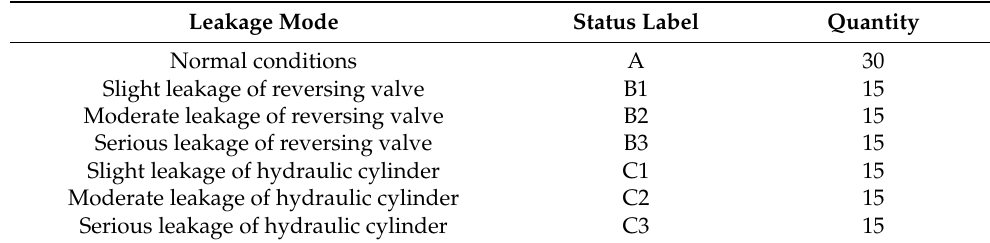
Table 12. Test set of leakage